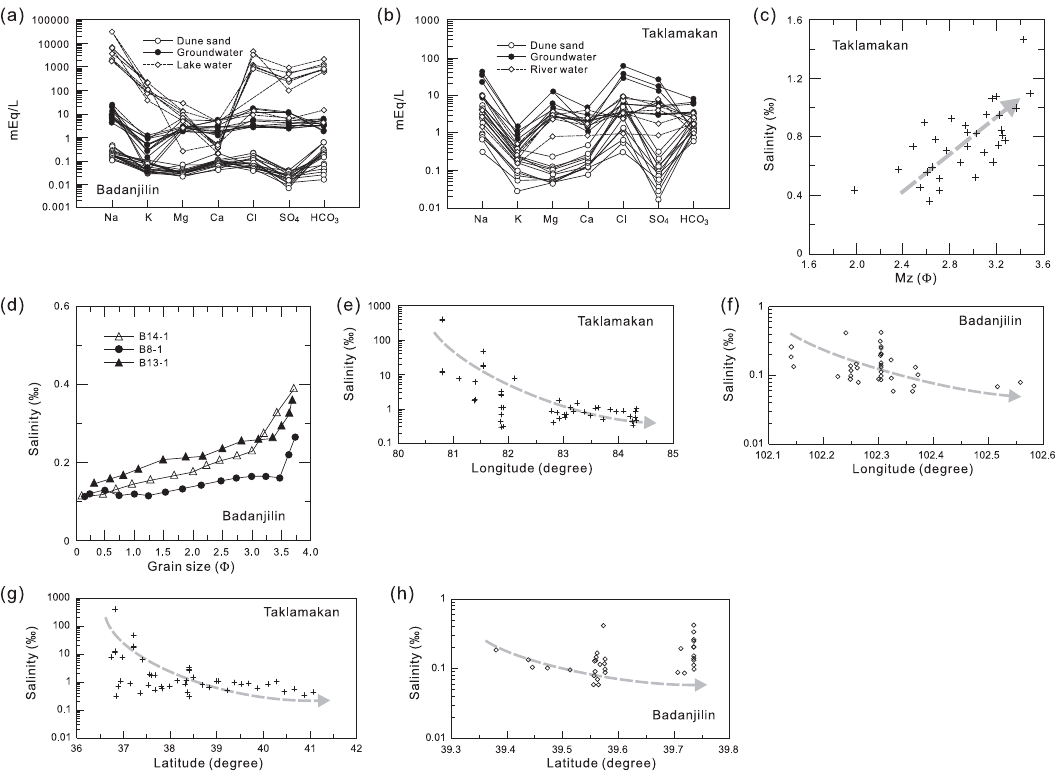
Figure 5. Distribution patterns of the major ions of aeolian salts, groundwaters and lake waters in (a) the Badain Jaran Desert and (b) the Taklamakan Desert. The data of local lake water and groundwater bodies in the Badain Jaran are cited from Yang and Williams (2003), and the river water and groundwater bodies in the Taklamakan from Zhu and Yang (2007). The relationship between salinities and grain size compositions of the aoelian sediments: (c) salinity vs. median particle diameter (Mz, in phi unit) of dune-surface sediment from the Taklamakan Desert, and (d) salinity vs. grain size compositions of randomly selected dune sediments from the Badain Jaran Desert. Spatial distributions of the salinities of the aeolian sediments along the longitudinal and latitudinal degrees in the Taklamakan Desert (e, g) and in the Badain Jaran Desert (f, h) ,